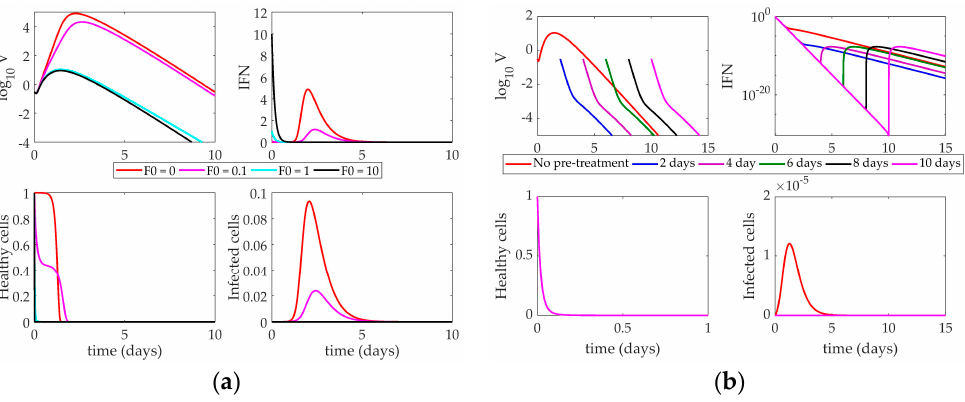
Figure 6 Figure 6. ( a ) Response of Saenz model to increasing IFN on day 0. Lines correspond to different values of F0 (initial condition of interferon); ( b ) Impact of IFN pre-stimulation scheduling on the Saenz model. IFN treatment is given on day 0 and patients are simulated to become infected 2, 4, 6, 8, or 10 days after treatment.